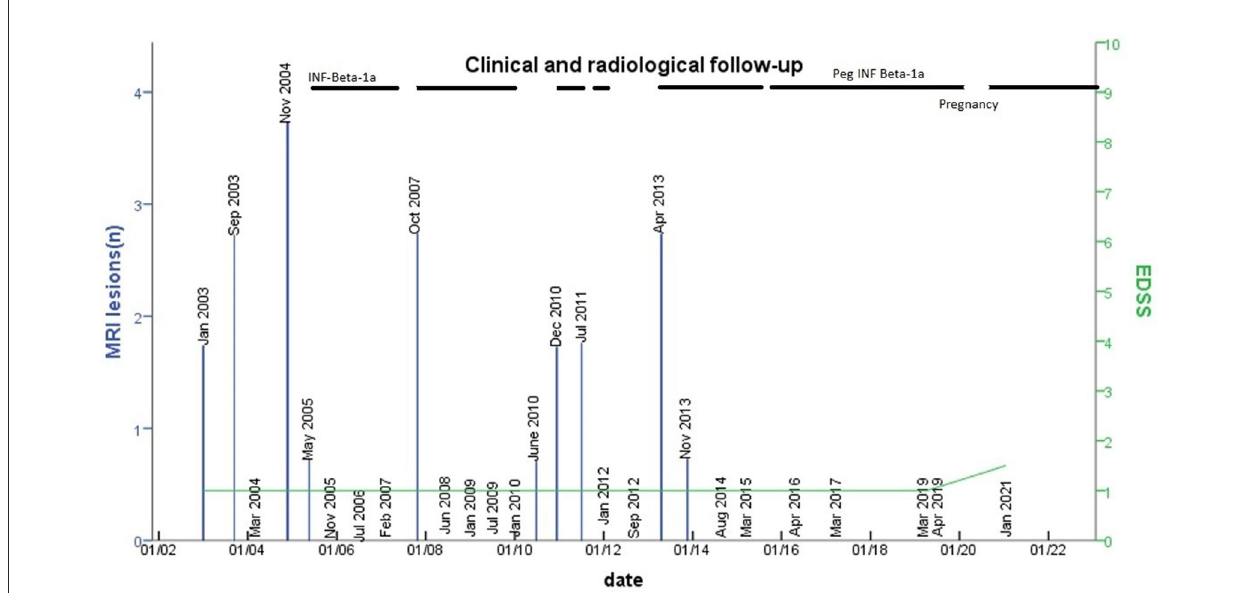
FIGURE2 The number of new lesions in MRI follow-up and EDSS change. The number of lesions detected on MRIs performed during the follow-up is shown (blue columns). The x-axis represents time, the yaxis represents the number of new lesions on MRIs and EDSS. At the top of the table, the line stands for the time under treatment with INF beta or peginterferon. The dashed line stands for periods of irregular intake of the